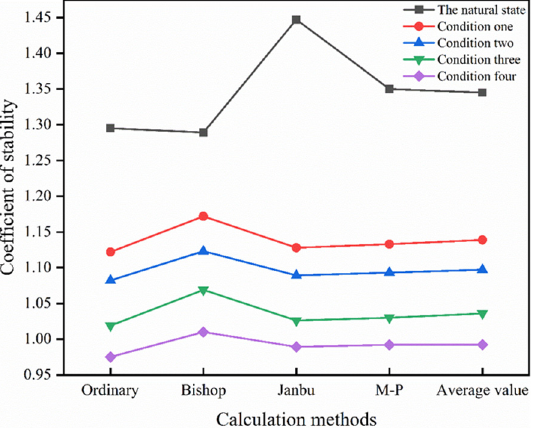
Figure 6. Statistics of stability coefficients for different working conditions in the study area.